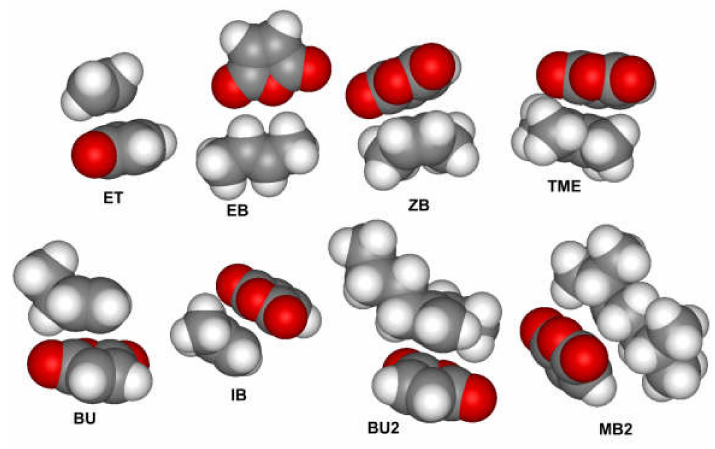
Figure 1. Optimized geometries of the adducts of MA and olefins.